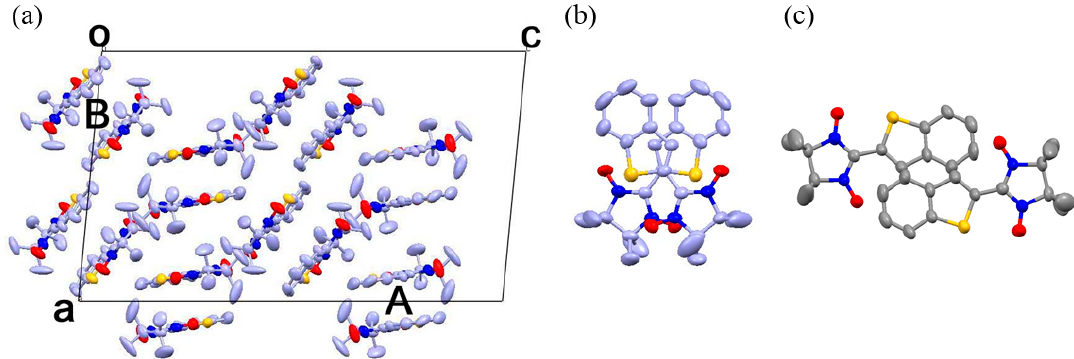
Figure 7. ( a ) An ORTEP view of the crystal structure of 2-BTHNN along the b axis. “A” and “B” denote the two kinds of molecular dimers. Molecular conformations of two neighboring 2-BTHNN in dimer A ( b ) and dimer B ( c ).